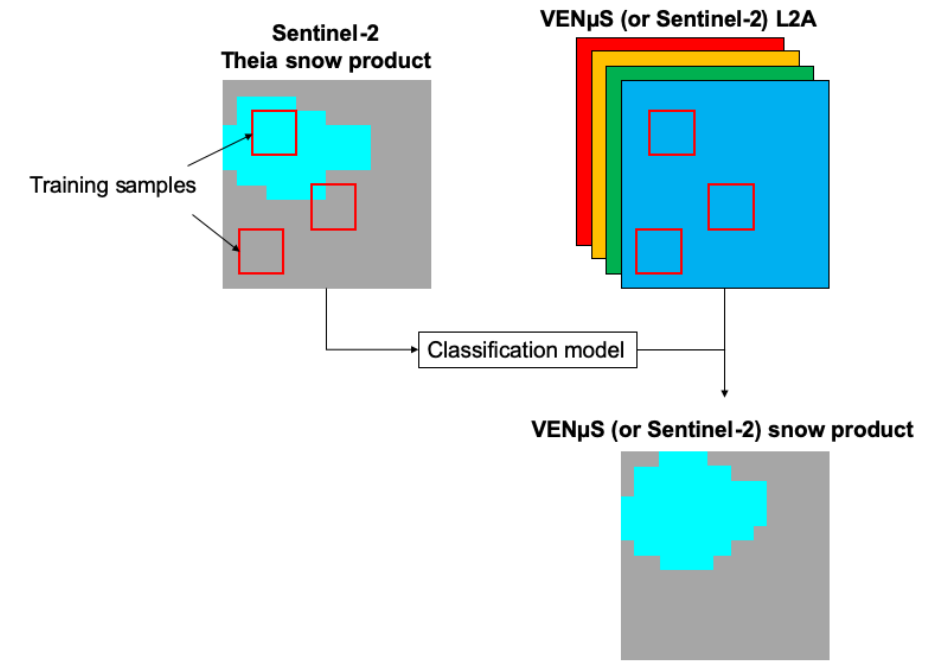
Figure 1. Workflow for the supervised classification. The red rectangles represent the random training